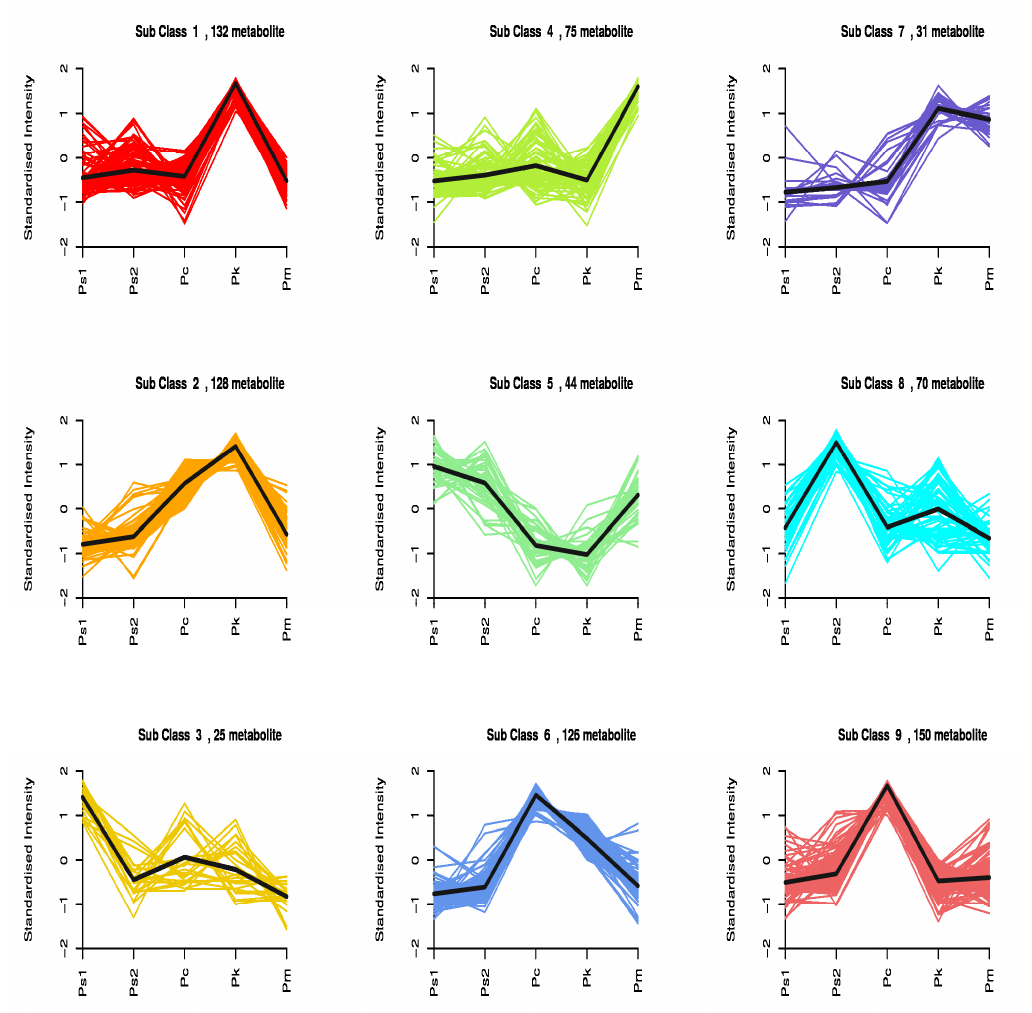
Figure 4. k-means cluster analysis of differential metabolites.